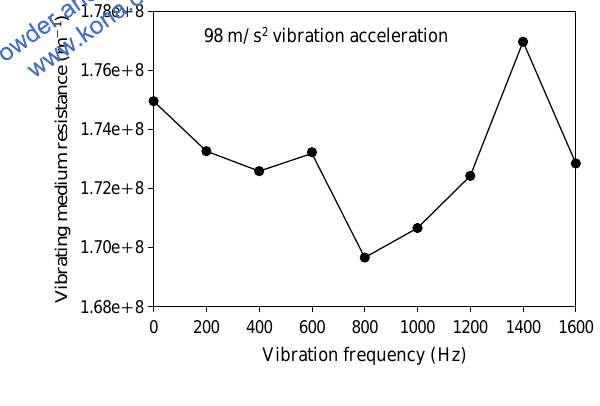
lower vibration accelerations, the shape of cake was as shown in Figure 8(b) , whilst at higher vibration accelerations, the form of the cake was as shown in Figure 8(c) . The “cake” in Figure 8(c) does not cover the filter medium, but exists as a dense “cloud” of particles lying just above the medium. There are zones around the “cloud” through which liquid is able to flow freely and which appear to have particle con- centrations similar to the feed suspension. At 500 Hz, for example, the formation characteristics of the cake changed from that depicted in Figure 8(b) at 196 m s (cid:2) 2 to that shown in Figure 8(c) at 294 m s (cid:2) 2 . ) during filtration Combined cake resistance ( R cv After filtration a typical thickness of cake was 27 mm. The pressure exerted on the cake was about 1638 Pa for a suspension with a depth of 196 mm in